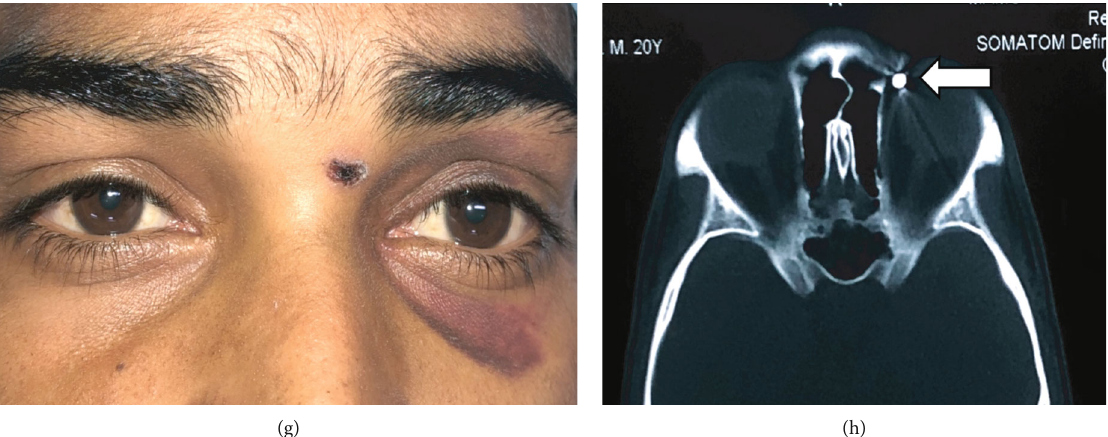
Figure 1: (a) Clinical photograph showing purulent discharge in the left medial canthal area and (b) retrieved wooden IOrbFB in case 6. (c) Clinical image showing orbital in fl ammation and (d) retrieved wooden IOrbFB in case 5. (e) Clinical picture depicting an entry wound below the right lower lid and (f) radiological image showing a linear metallic foreign body along the orbital fl oor in case 7. (g) An entry wound in the glabellar region and (h) noncontrast CT orbit (axial view) suggestive of a metallic foreign body post-BB injury in case 4.